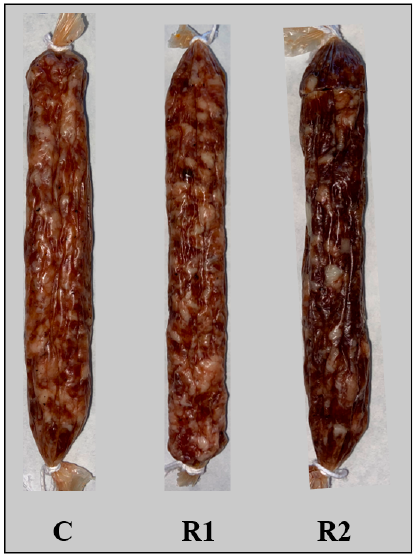
Figure 1. Fuet sausage and formulations. C: control with regular fat content; R1: reduced fat with inulin + β -glucan; R2: reduced fat with inulin + β -glucan + grape skin.